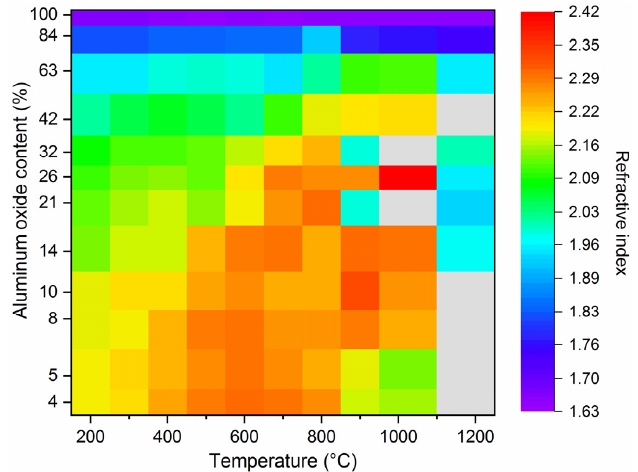
Figure 2. Evolution of refractive indexes of titania thin films according to the alumina content and annealing temperature ranging from 200 to 1200 °C with a dwell time of 60 min and a heating rate of 1 °C/min. Grey boxes indicate measurements at which the fit in spectroscopic analyses did not converge, indicating discontinuous thin films.